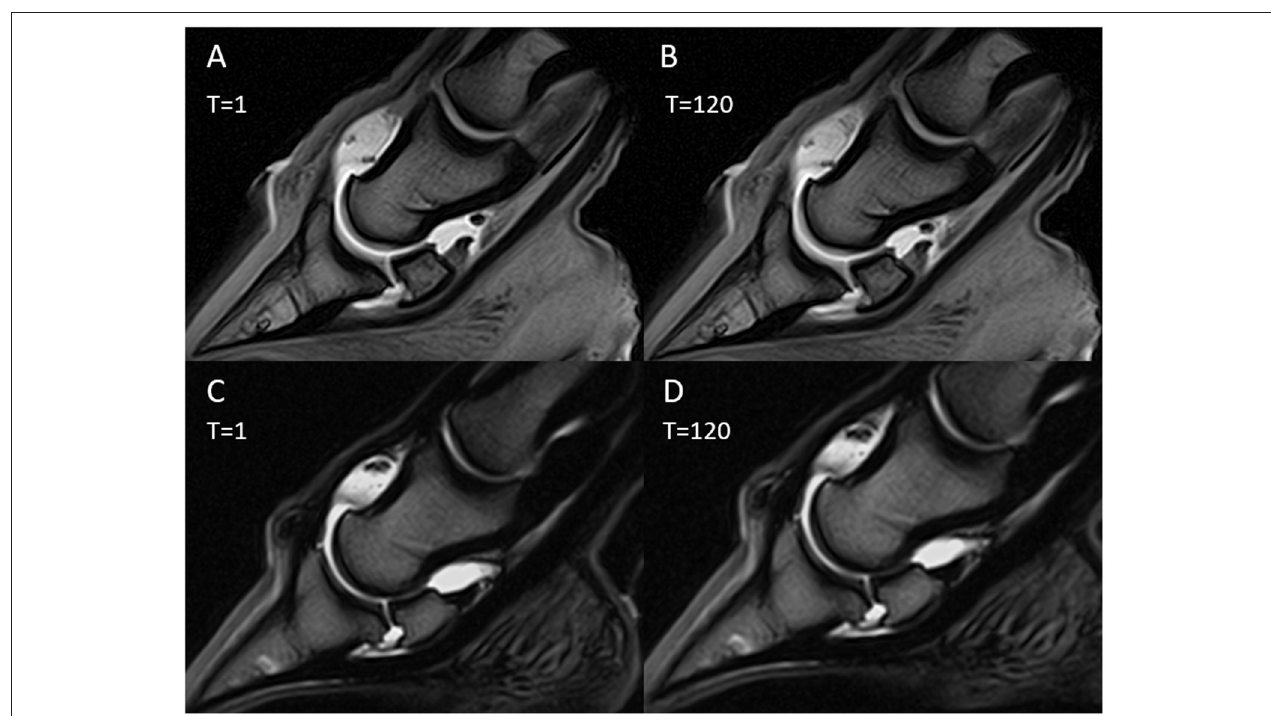
FIGURE 6 | Magnetic resonance (MR) arthrography images immediately after contrast medium injection ( T = 1) and after 120min ( T = 120). Sagittal T1-weighted images with gadolinium injection (A,B) ; sagittal T2-weighted images with saline injection (C,D)